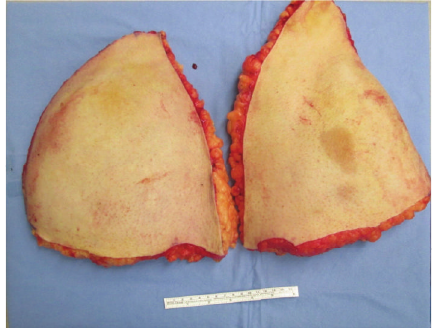
Figure 2: Panniculectomy specimen, weighing 3.9